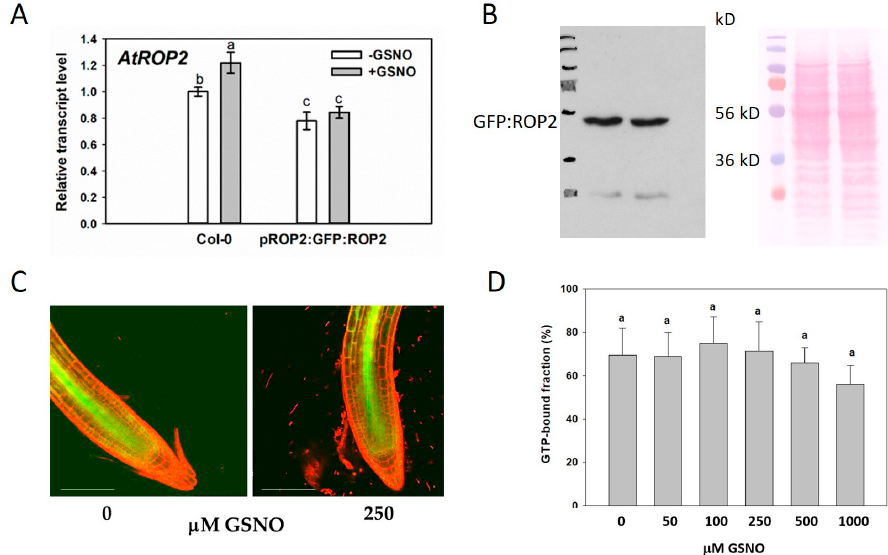
Figure 3. ( A ) Relative transcript level of ROP2 in control and 250 µ M GSNO-treated Col-0 and pROP2:GFP:ROP2 Arabidopsis. Data were normalized using the A. thaliana ACTIN2 and GAPDH2 genes as internal controls. The relative transcript level in Col-0 control samples was arbitrarily con- sidered to be 1. Data were averaged from three biological repetitions with three technical replicates each. ( B ) Western blot analysis of GFP:ROP2 abundance in the root of rop2-1 /pROP2:GFP:ROP2 Ara- bidopsis treated with 0 (-GSNO) or 250 µ M GSNO using anti-GFP antibody. ( C ) pROP2:GFP:ROP2 fluorescence in Arabidopsis root tips treated with 0 or 250 µ M GSNO. ( D ) Binding efficiency of 6xHIS:ROP2 to GTP-agarose without (DMSO) or with the indicated concentrations of GSNO treat- ment. The percentages of input ROP2 bound to and eluted from GTP-agarose are shown. The data are average and standard deviation for three independent experiments with two technical repetitions each. Different letters sign significant difference at the p < 0.05 level based one one-way ANOVA and Duncan’s